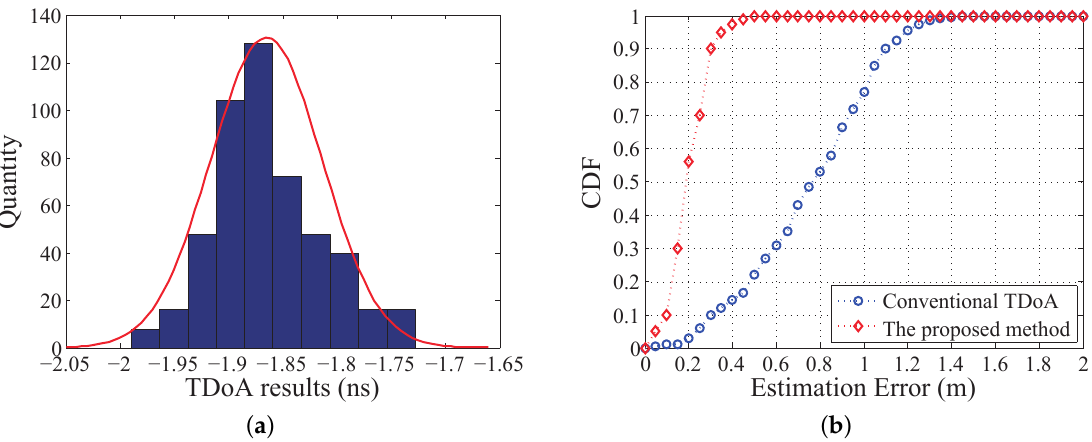
Figure 15. Experimental results of 2D position sensing: ( a ) Histogram of TDoA results distribution with the mobile node at a fixed test position; ( b ) Cumulative distribution function of estimation errors by using two